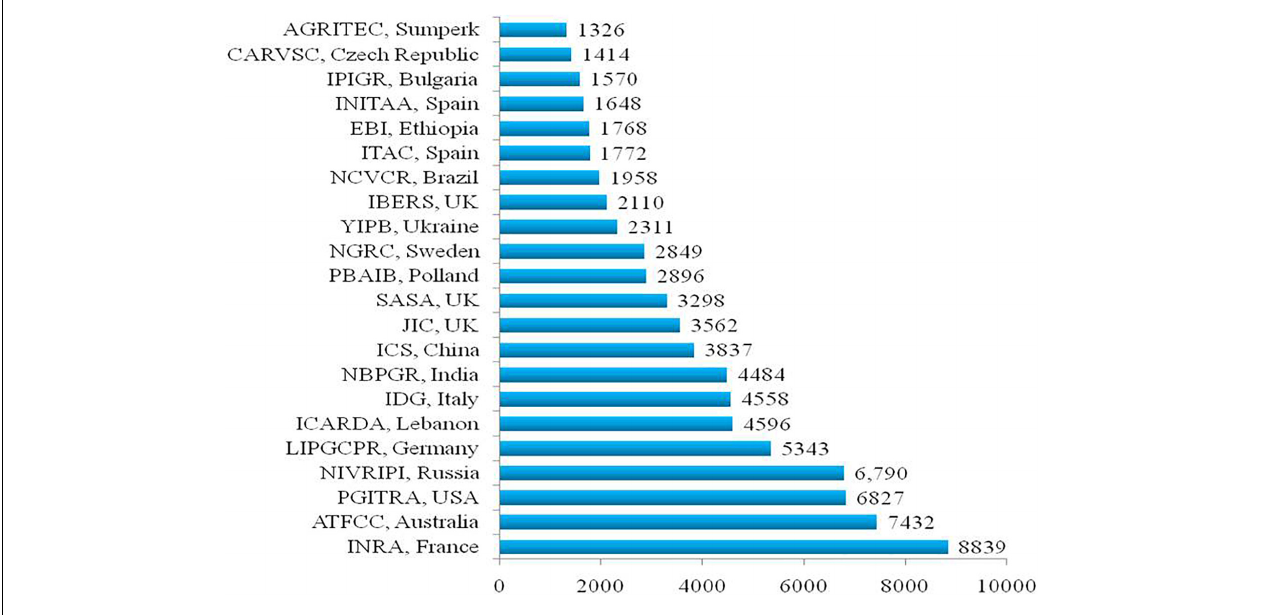
FIGURE 1 | Major pea germplasm holding organizations worldwide (Warkentin et al., 2015;